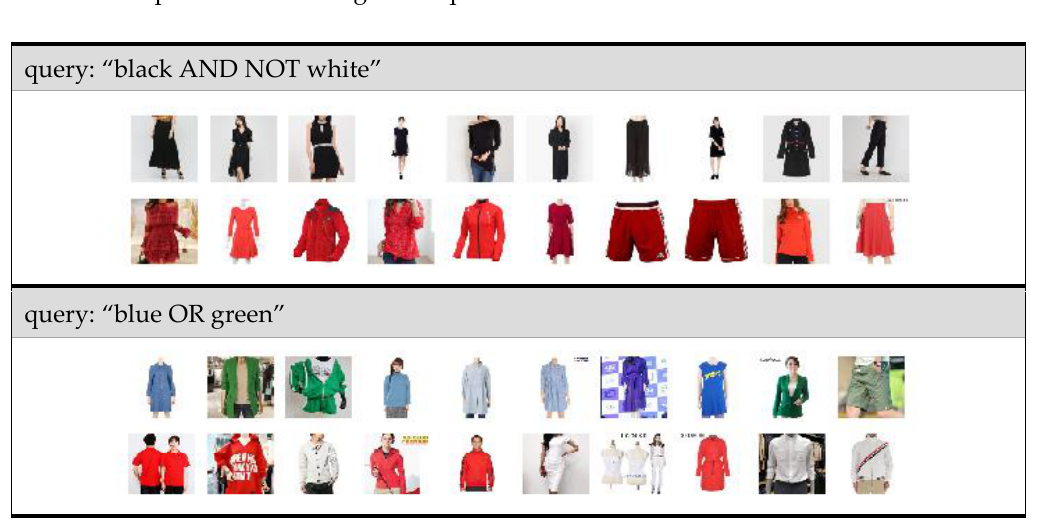
Figure 9. Fashion product search results for queries with Boolean expressions.